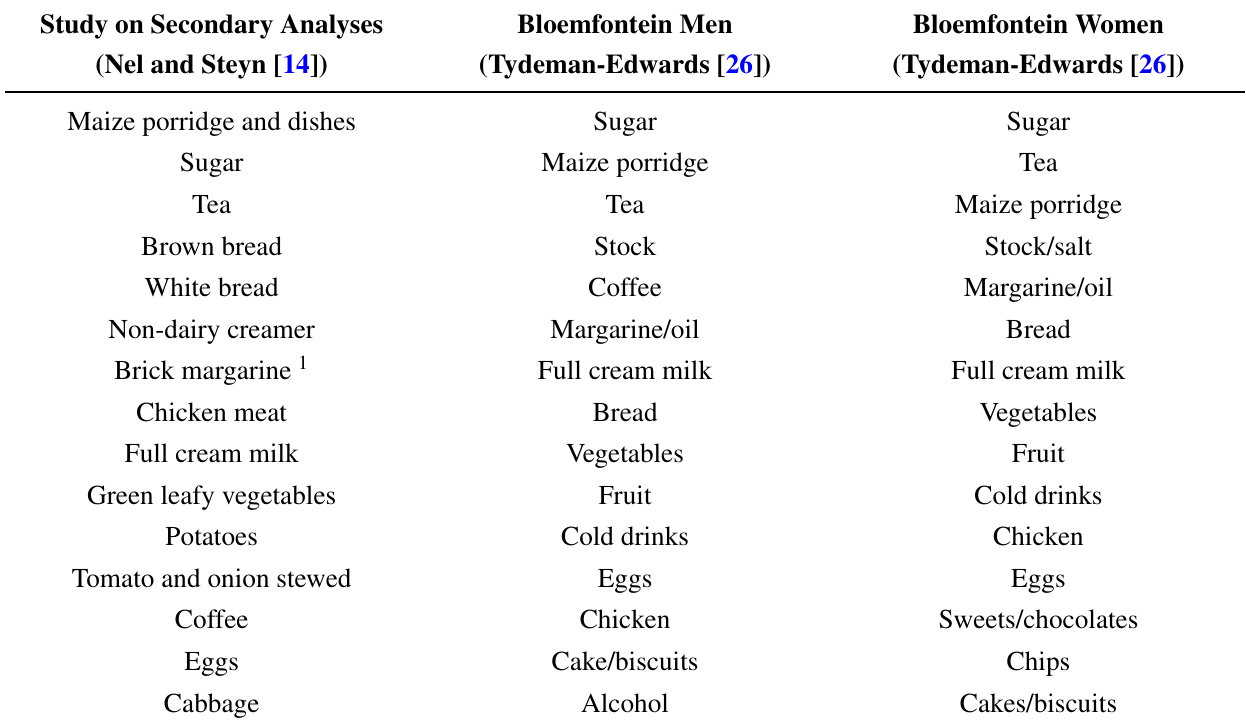
Table 5. Comparison of 10 most frequently consumed foods by South Africans. Study on Secondary